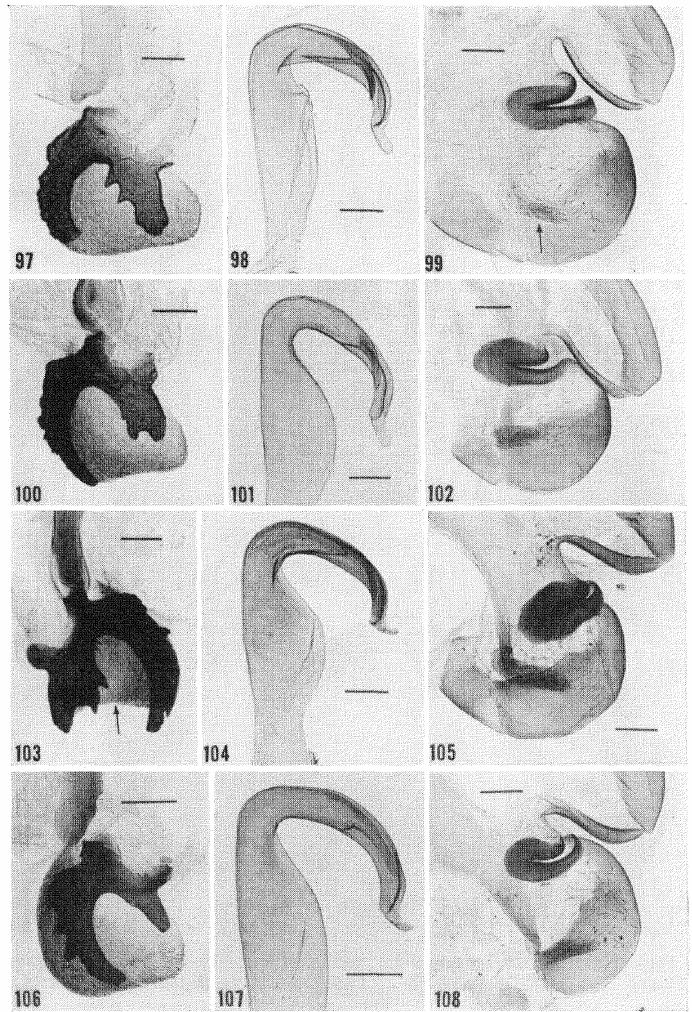
Figs. 97-1(18. Cockroach male genitalia. Eplampra }orgenseni. 97-105. Paratypes of Epilampra stigm’atiphora Rehn (--- E. )orTenseni). Misiones, Argentina. 97-99. (86 ANSP). (arrow in 100 indicates setal brush). 100- 102. (96 ANSP). 103-105. (48 ANSP). (Fig. 103 is a ventral view; part of the prepuce (arrow) in this specimen is missing). 106-109. (164 USNM). Between Coronel Oveido and Asuncion, Paraguay (det. Roth). (scale 0.2